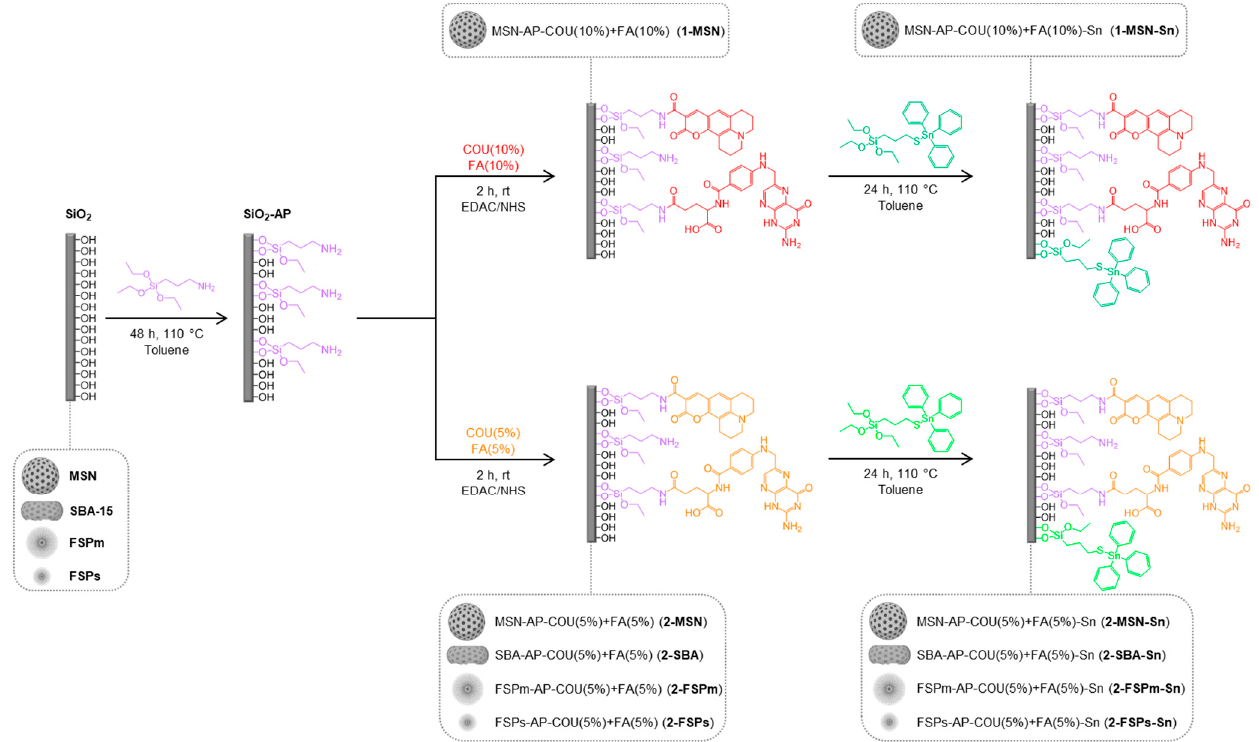
Scheme 1. Synthetic routes in the preparation of the functionalized